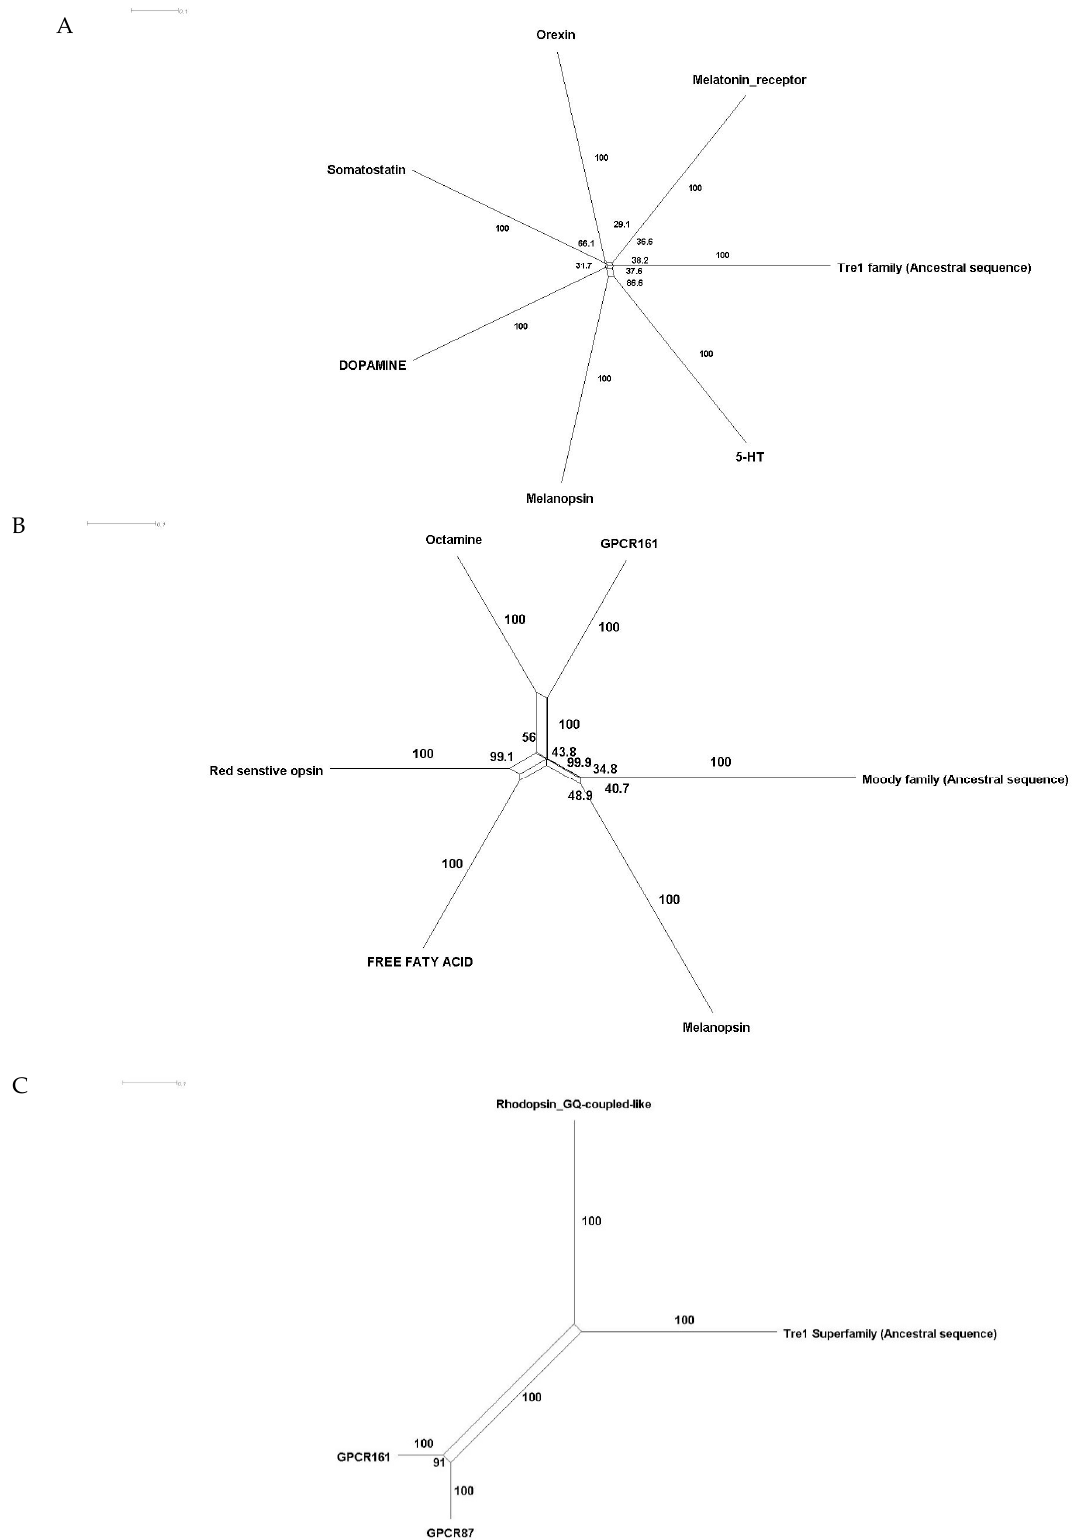
Figure 2. Ancestral sequence construction and network tree for family Tre1. We used the Amphimedon queenslandica (Sponge) genome to locate putative common ancestors for the family Tre1 family. ( A ) The nearest common ancestor for Tre1 melatonin, somatostatin, dopamine receptors, and melanoopsin. ( B ) The nearest common ancestors to moody divergence are melanopsin and GPCR161. ( C ) Tre1 family nearest common ancestors compromise rhodopsin GQ-coupled, GPCR161, and GPCR87.